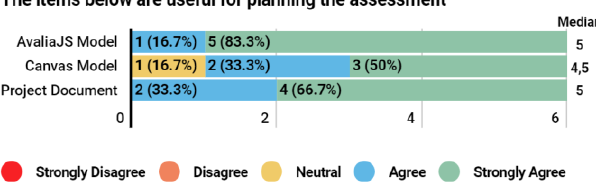
Figure 13. Experts’ answers regarding the usefulness (item 11) of the AvaliaJS